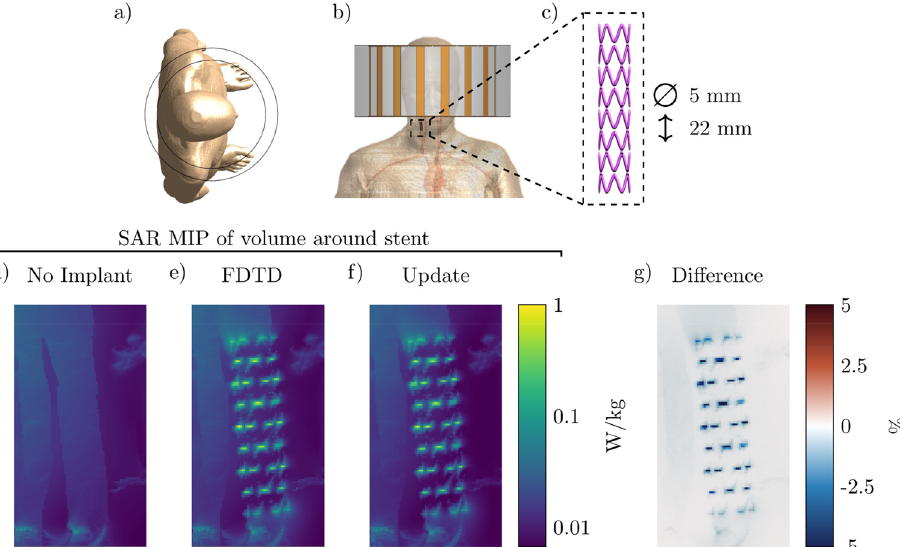
Figure 4. Proposed method applied to calculate the SAR increase for a carotid stent. ( a ) and ( b ) Transverse and coronal view of the simulated setup, respectively. ( c ) The model of the simulated stent. ( d ) Maximum Intensity Projection (MIP) of the local SAR without implant. ( e ) and ( f ) The MIPs of the local SAR with the implant present using the FDTD and the proposed method respectively. ( g ) The MIPs of the difference between the FDTD and the proposed